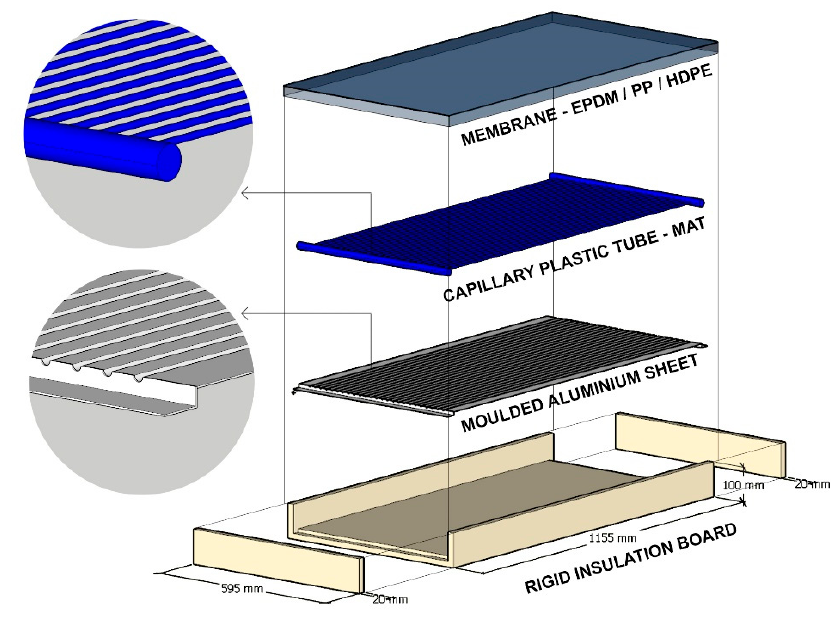
Figure 15. Components of a condensation-resistant radiant cooling panel. Source: First author.